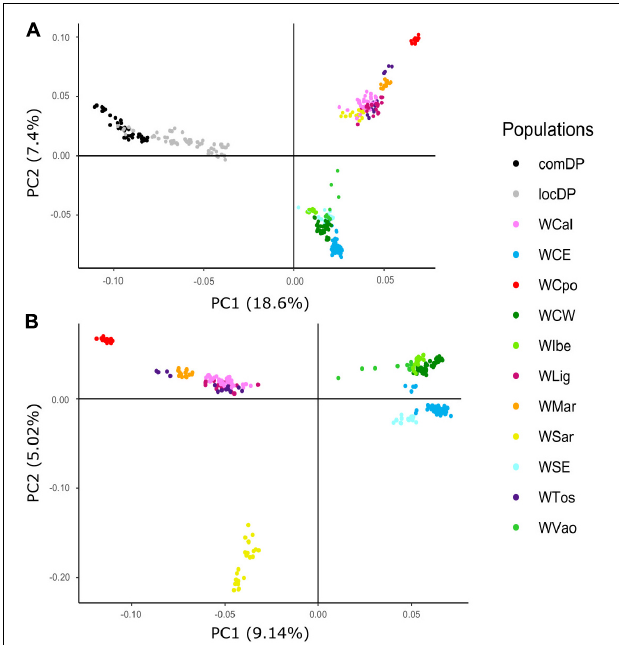
FIGURE 2 | Principal component analysis (PCA) computed using wild boar (WB) and domestic pig (DP) 30K genotypes. Plots show relative genomic distances among sampled individuals in (A) Italian WB, European WB, and local and commercial DP breeds and (B) Italian and European WB